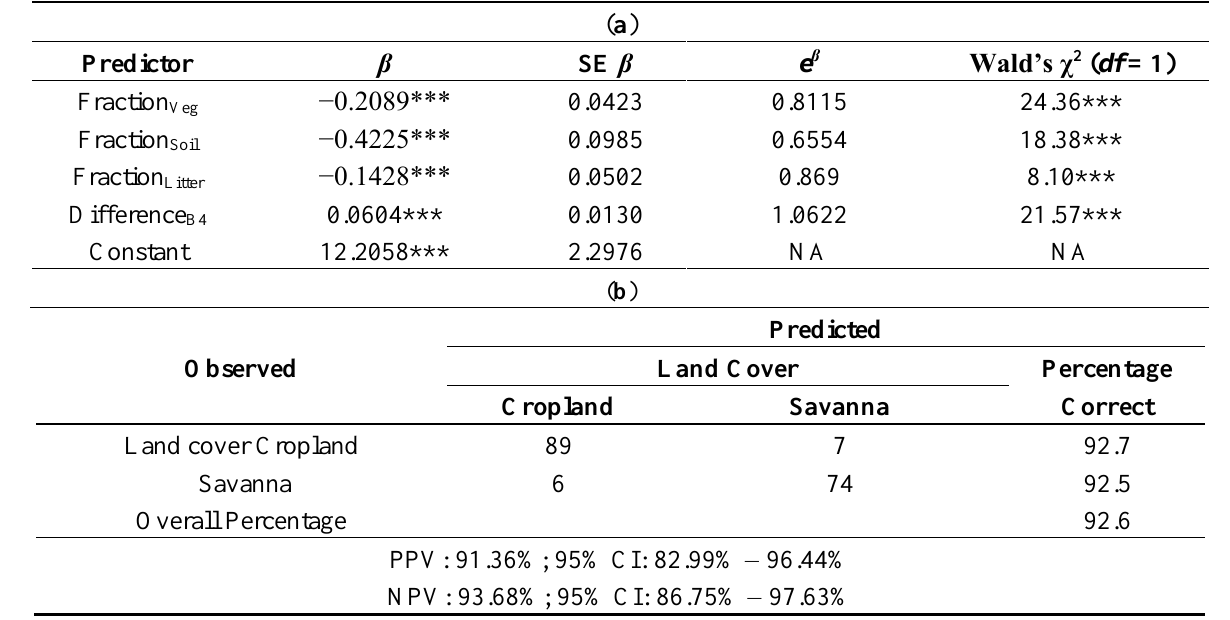
Table 3. ( a ) Summary of predictor effects for cropland_3 subgroup model. ( b ) Classification table for cropland_3 subgroup model. Classification cutoff value is 0.500. PPV = Positive predicted value and NPV = Negative predicted